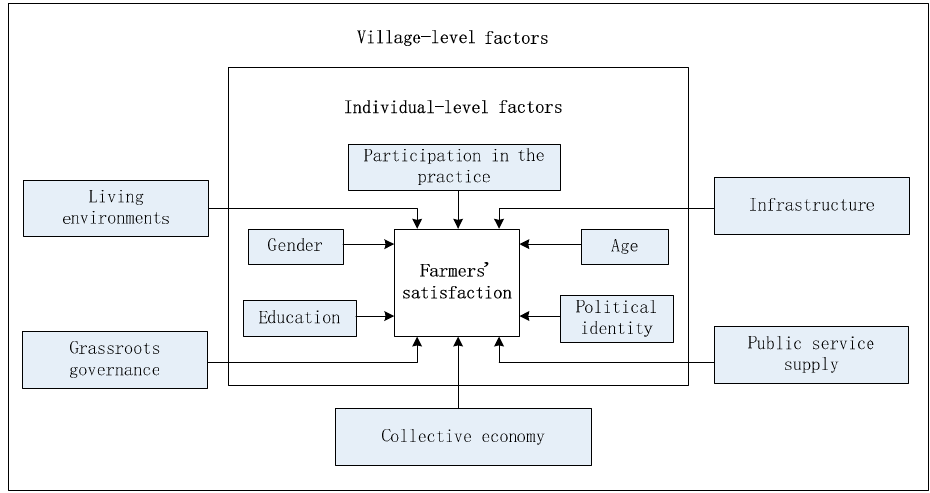
Figure 1. Study conceptual